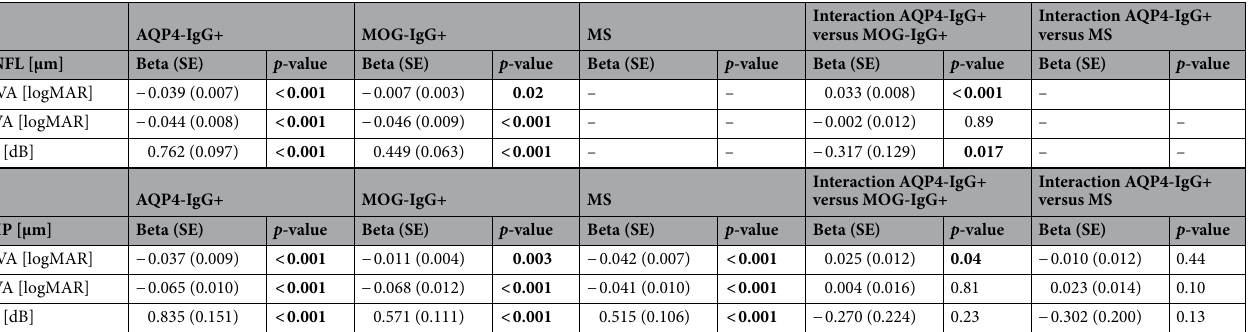
Table 3. Structure–function associations for pRNFL and GCIP below 60 µm. Association between different measures of visual function and pRNFL- and GCIP-thickness respectively in a mixed linear spline model of NMOSD, MOGAD and MS eyes as well as interaction effects between the patient groups; all values are only from the sloped part of the spline for pRNFL and GCIP thickness values lower than 60 µm respectively (Fig. 2). No associations between pRNFL and visual function are provided for MS-eyes as there were not enough eyes below the 60 µm cutoff. AQP4-IgG + aquaporin-4 antibody positive NMOSD, MOG-IgG + myelin- oligodendrocyte-glycoprotein associated disorder, MS multiple sclerosis, SE standard error, HCVA high contrast visual acuity, LCVA low contrast visual acuity, MD mean deviation, pRNFL peripapillary retinal nerve fiber layer, GCIP combined ganglion cell and inner plexiform layer. Significant values are in